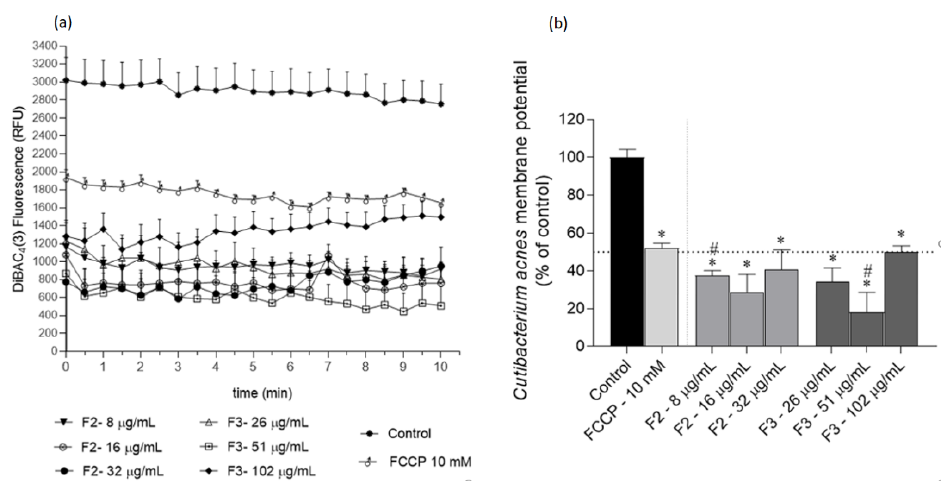
Figure 3. Cutibacterium acnes membrane potential when exposed to Gelidium corneum F2 (water insoluble) and F3 (diethyl ether) fractions at ½ IC 50 ; IC 50 and 2 × IC 50 , labelled with DiBAC 4 (3) probe; ( a ) 30 s interval readings; ( b ) after 10 min. FCCP (10 mM) was used as positive control and DMSO as negative control. Each value and bars represent the average of three independent experiments. Vertical lines represent the standard error of the mean (SEM). Symbol (*) represents significant differences when compared to the control. Symbol ( # ) represents significant differences when compared to FCCP (ANOVA, Dunnett’s test, p < 0.05).